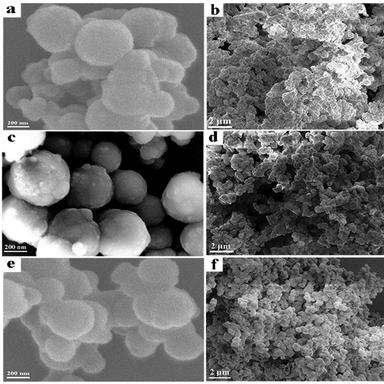
SEM images of (a, b) MPCM4, (c, d) MPCM3, and (e, f) MPCM5.